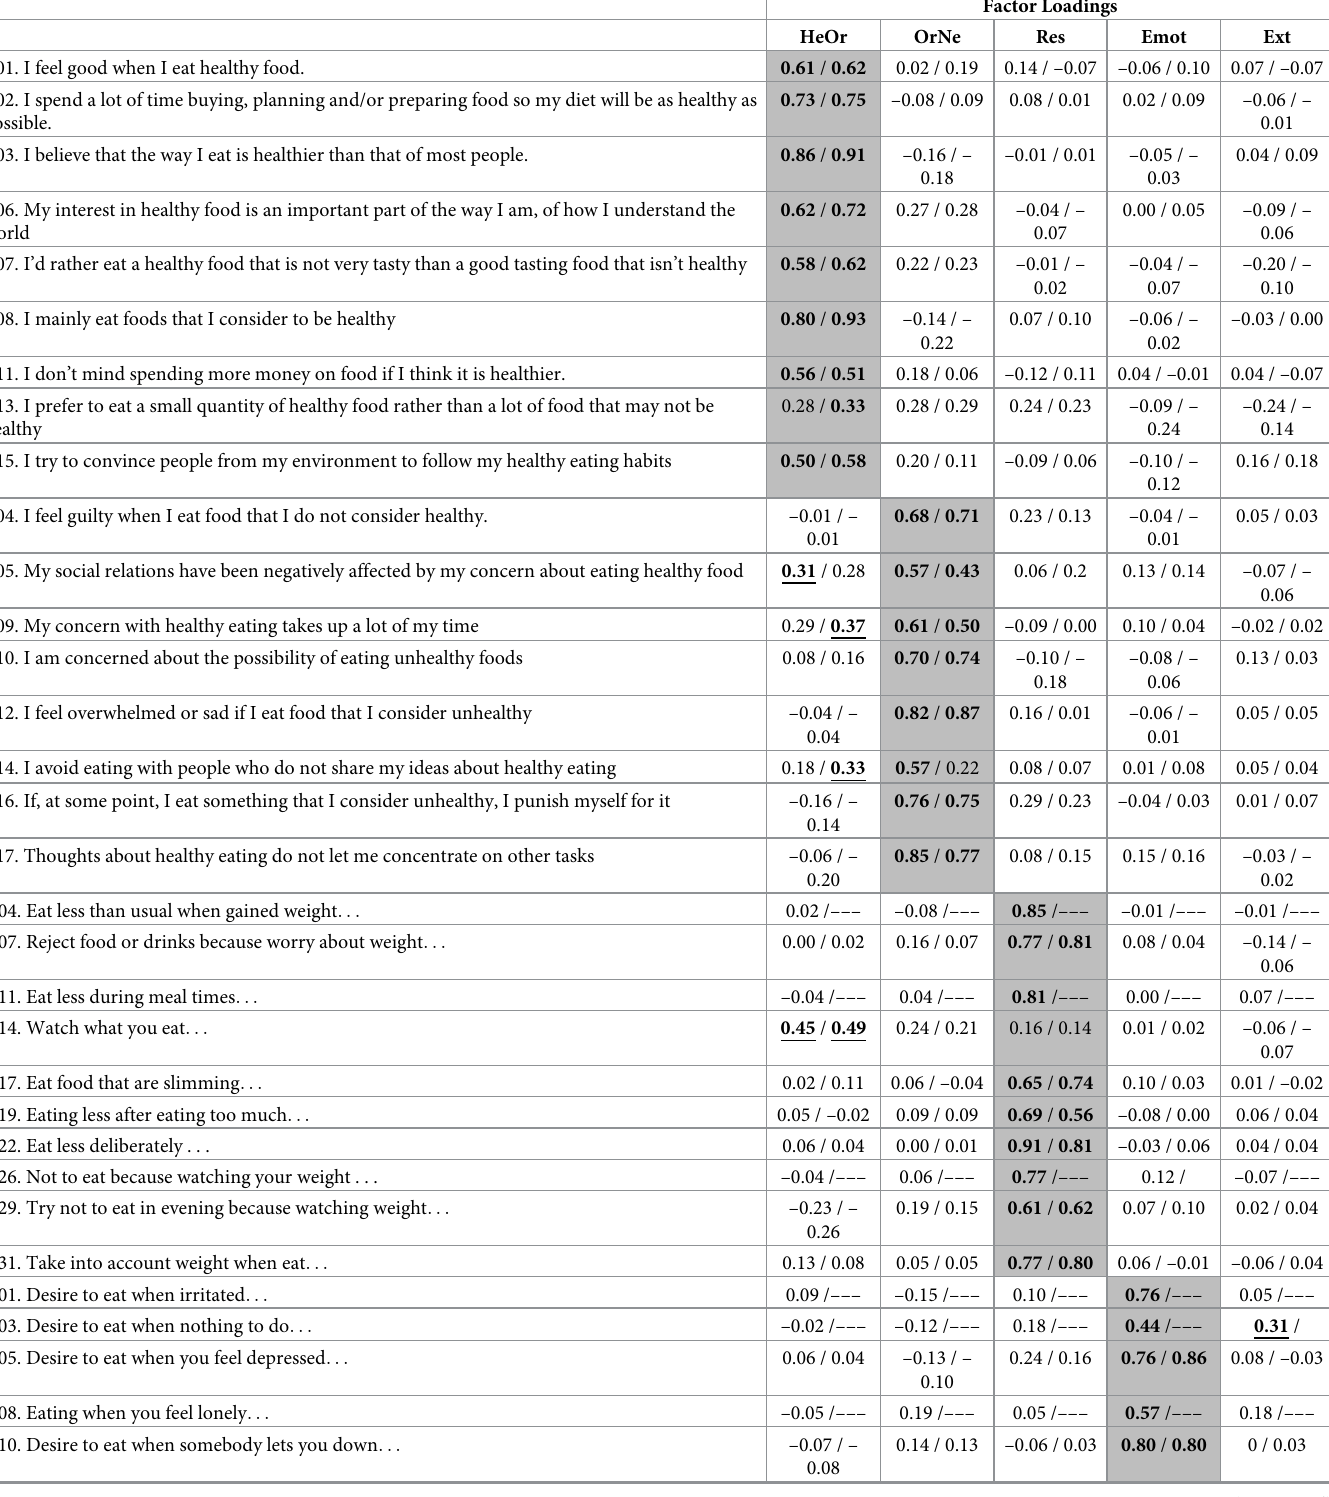
Table 3. Item loadings and interfactor correlations for the Teruel Orthorexia Scale and the Dutch Eating Behavior